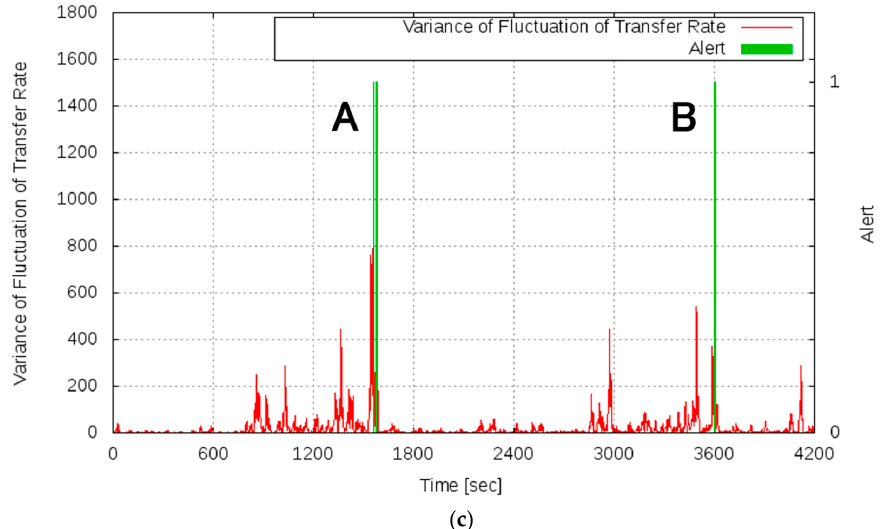
Figure 10. Results of measurements of the test bed system and generated alert; ( a ) server load (requests per second); ( b ) transfer rate; ( c ) variance of the fluctuation of the transfer rate and alert.